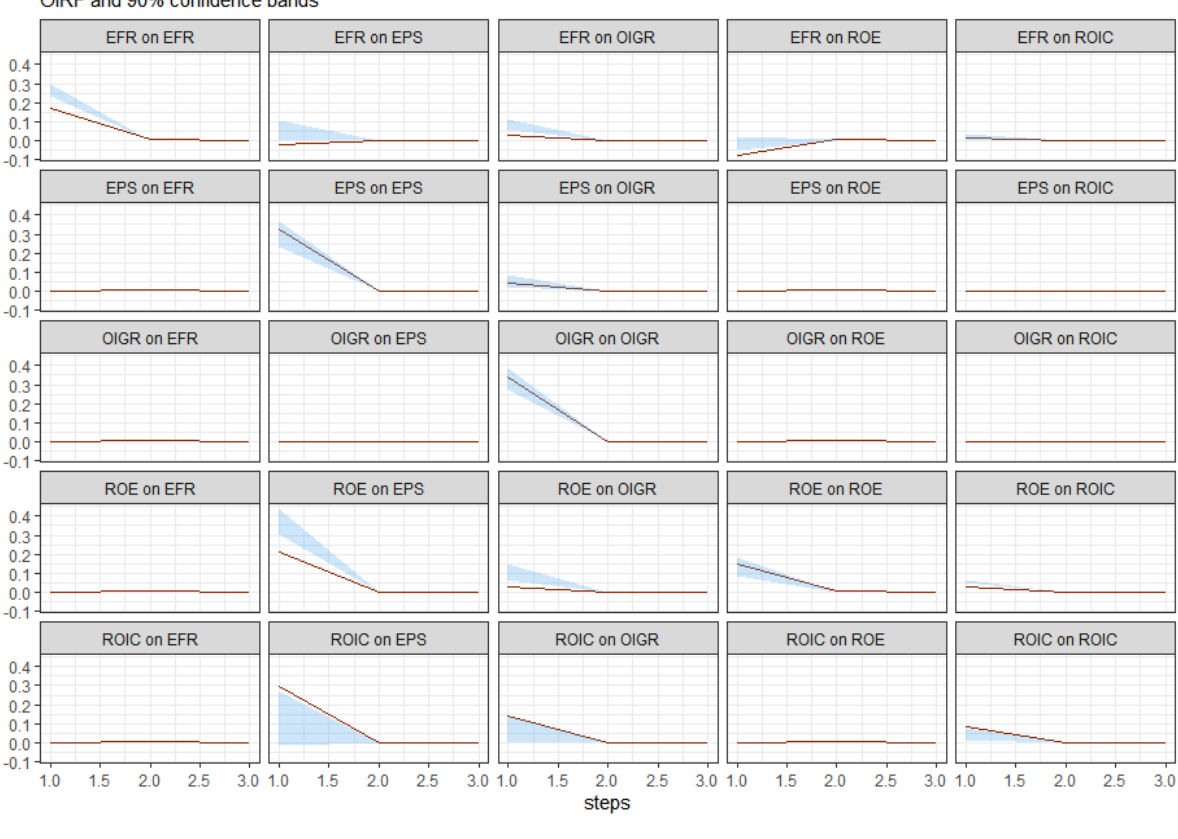
Figure 3. Impulse Response Function of model 2.